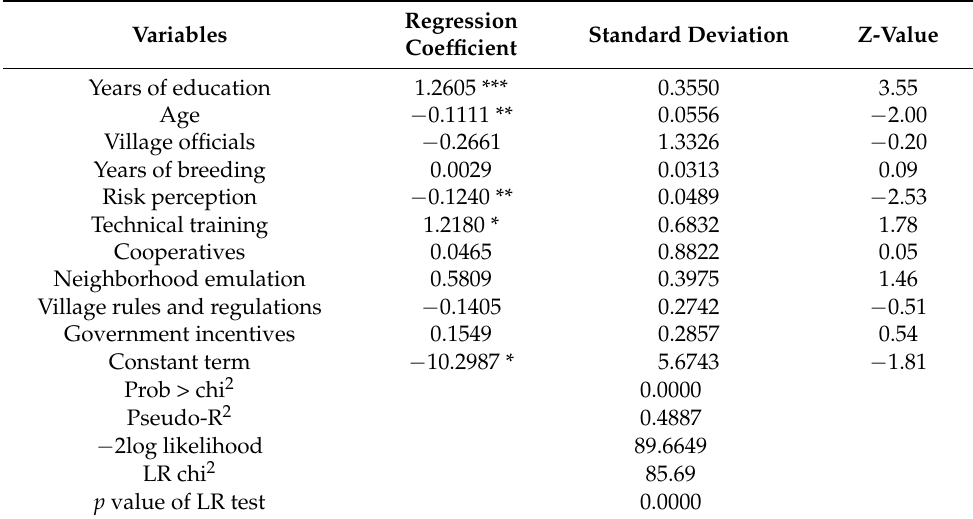
Table 6. The estimation results of digital technology application in dairy farms based on the Logit